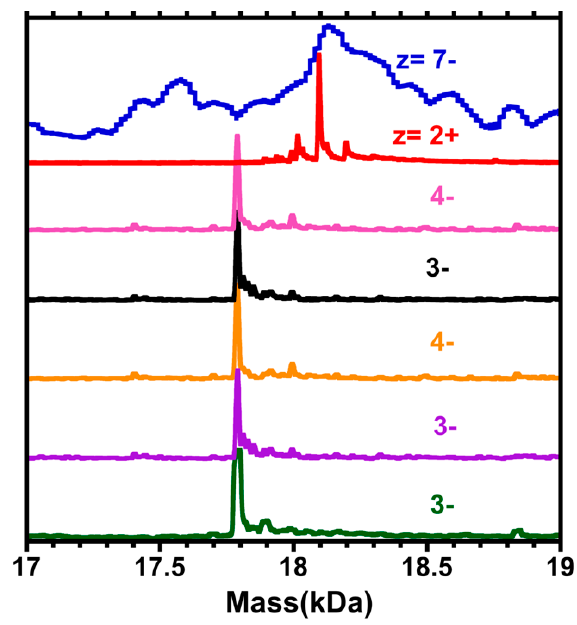
Figure 5. A comparison of the deconvoluted mass spectra in the region of the 17.8 kDa compound, putatively “Au 68 (3-MBA) 32 ”, vs. the ESI-MS of reference [1] (blue curve at top). Selected portions of the ESI mass spectra of gold cluster samples are depicted, in which the independent variable has been converted from the ( m / z ) scale to the total mass (kDa), using the charge (z) assignments indicated in Figure 2 (red), Figure 4 (pink and purple), Figure 1 (orange and black), and Figure 3 (dark green). Note that in the case of the positive ion mode (z = 2 + ), the peak is shifted higher by ~ + 0.3 kDa, consistent with three (3) TEAH + adducts, to the (67,30) 1 − complex. [Mass of TEAH + = 101 Da.].